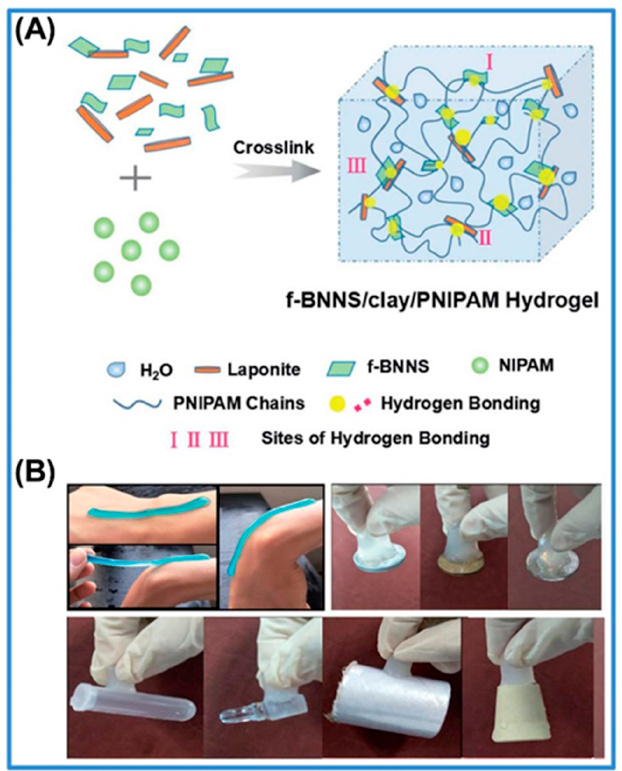
Figure 5. ( A ) Schematic illustration of the formation of the f-BNNS / clay / PNIPAM ternary network hydrogel. ( B ) Hydrogel adhesion on the arm, aluminum, copper, iron, plastics, glasses, polythene and rubbers. Adapted with permission from Ref. [133]. Copyright (2018) The Royal Society of Chemistry.